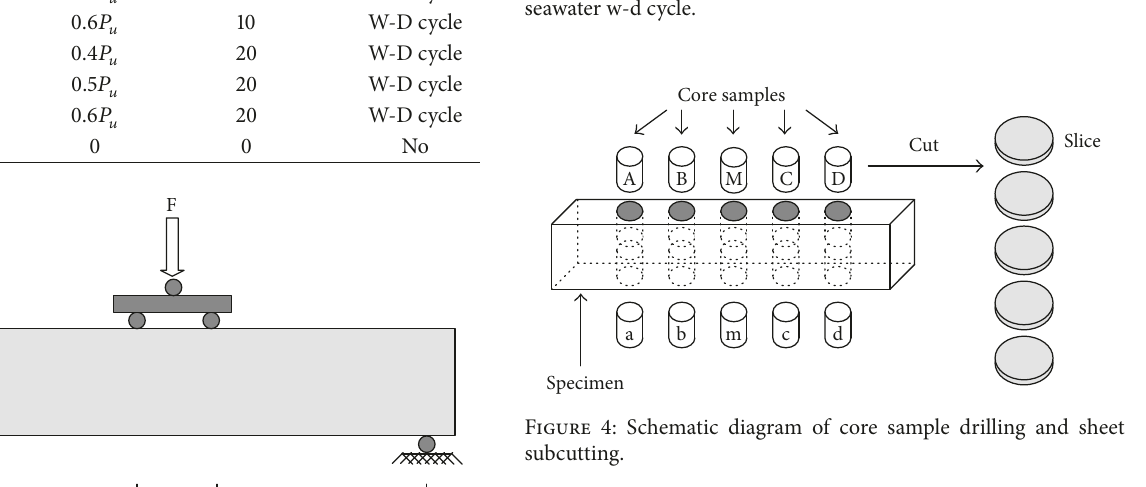
Figure 3: Schematic diagram of the automatic sprinkler system for seawater w-d cycle.